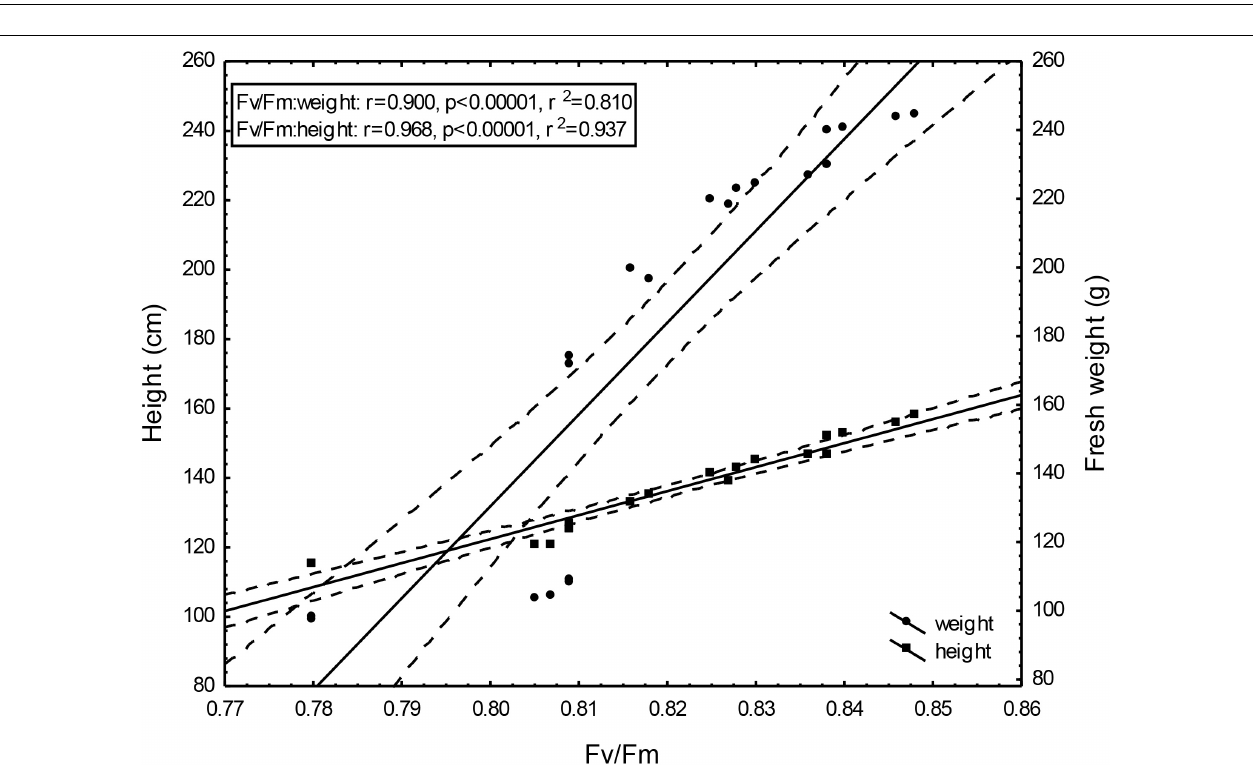
FIGURE 7 | Height and fresh weight regressions against Fv/Fm: Fresh weight = –1984.95 + 2645.99Fv/Fm; 0.95 C.L. Height = –430.44 + 691,05x; 0.95 C.L.